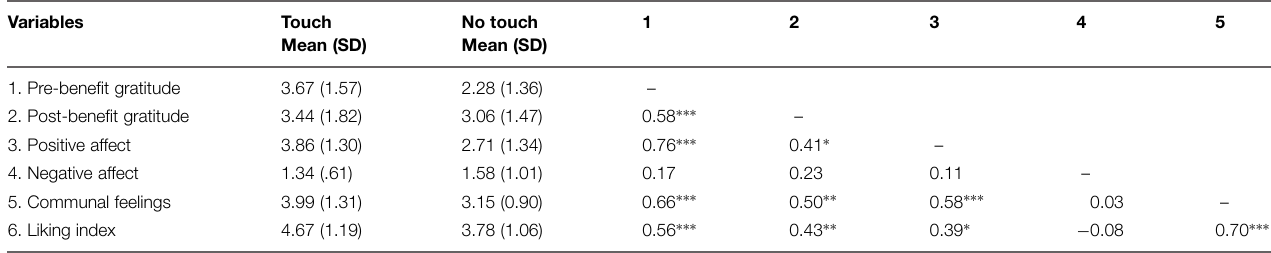
TABLE 1 | Means and SD as a function of touch, and correlations of pre- and post-benefit gratitude, positive and negative affect, communal feelings, and liking indices of Study 1 ( N = 36).